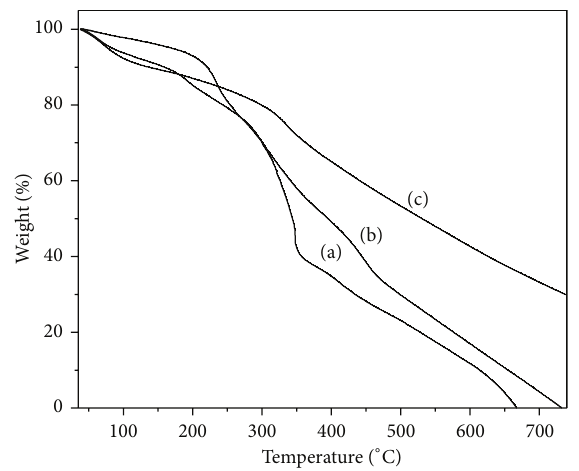
Figure 4: TGA curves of isomers of aminophenol: (a) PoAP, (b) PmAP, and (c)